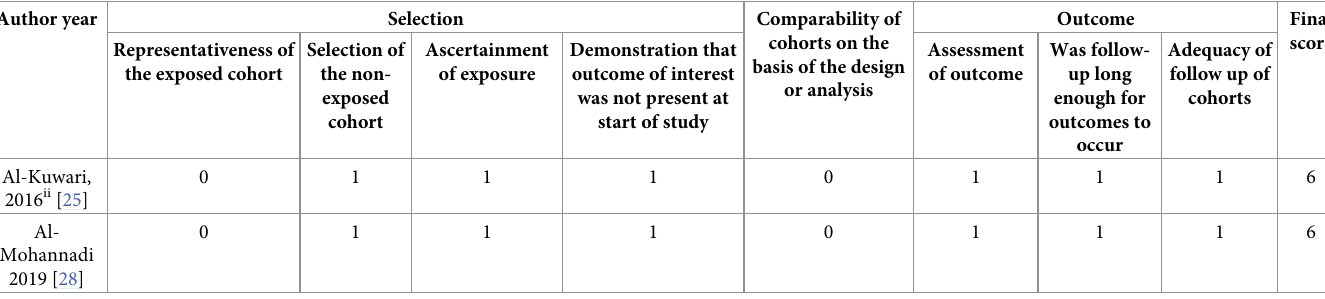
Table 2. Risk of bias summary for NRI studies using Newcastle Ottawa Scale.